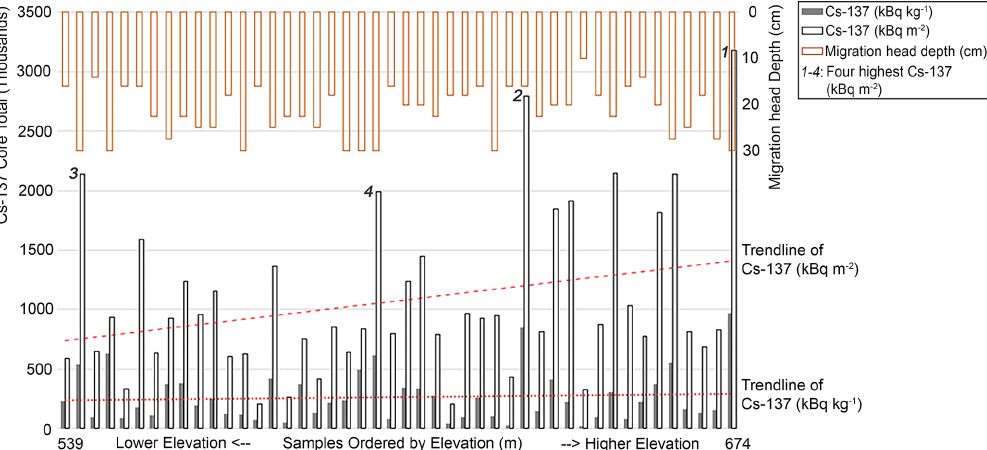
Figure 7. Core total Cs-137 in both units along the elevation (m). Numbers 1–4 indicate the samples with the four highest Cs-137 con- centrations in kBqm − 2 . Migration head depths (cm) are the depths at which Cs-137 concentrations decreased to 100Bqkg − 1 in a core sample.